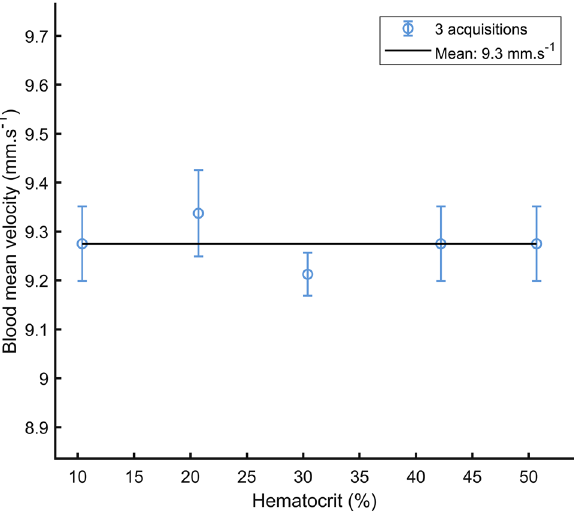
Figure 3. Measurement of mean blood velocity at a flow rate of 0.25 mL/min and for 5 hematocrit values. The measurement was performed from the blood volume ejected at the output of the experimental set-up during 4 min.